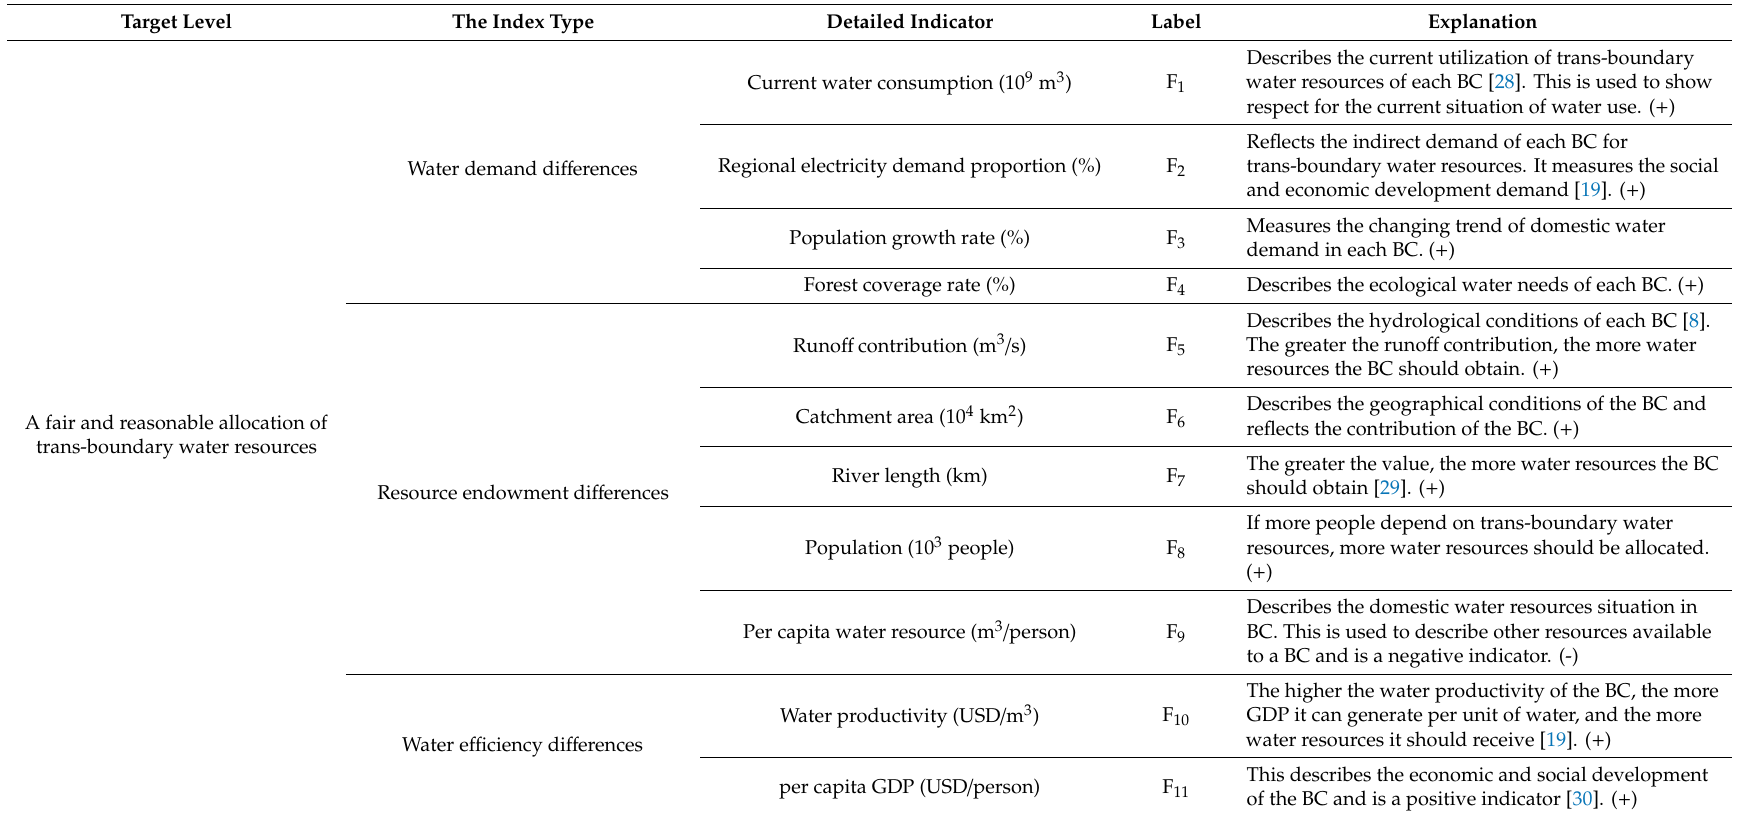
Table 1. Index system of water resources allocation in trans-boundary